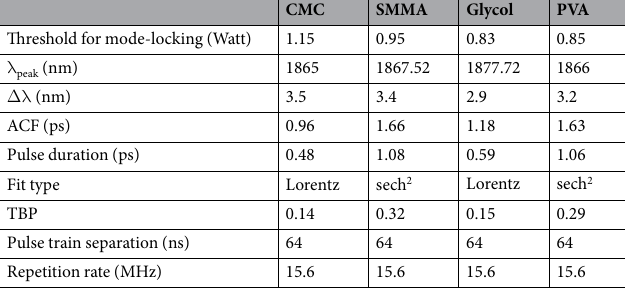
Table 1. Different parameters observed during the study.